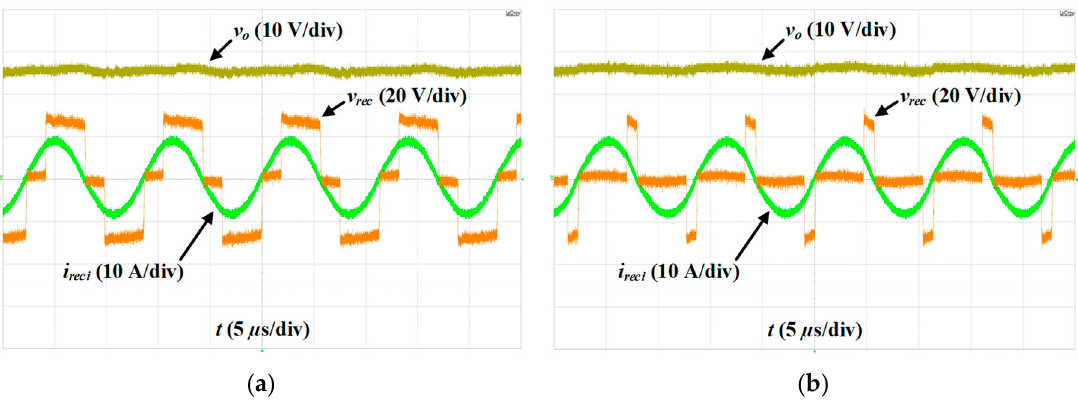
= 100 W; ( b ) P = 10 o o